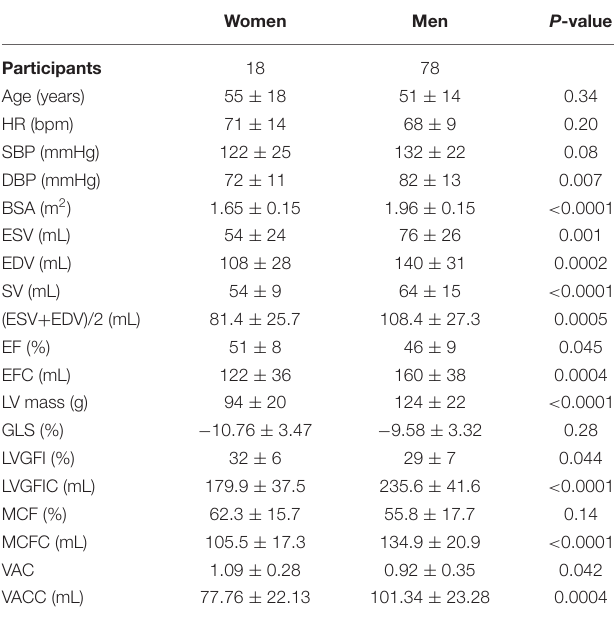
TABLE 1 | Baseline data for patients, stratified for